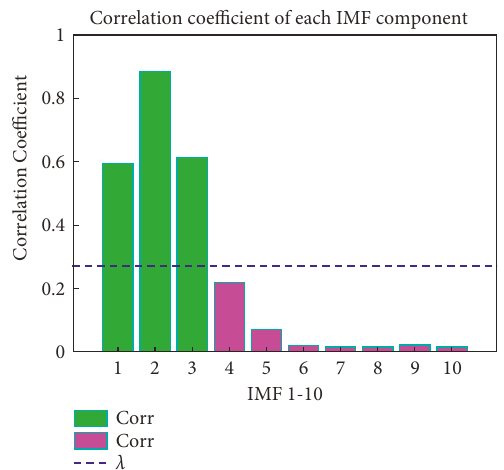
Figure 9: Correlation coefficient of each IMF component.